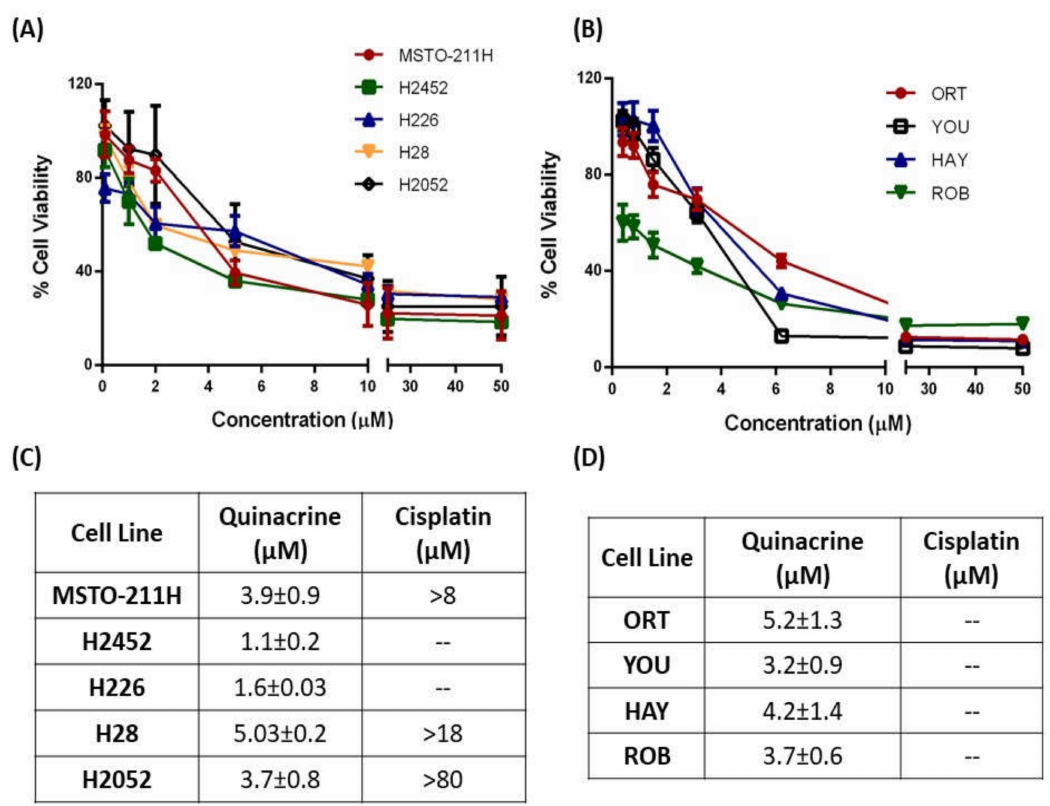
Figure1. Cytotoxicityscreenforquinacrine(QA)andcisplatin(CS)onimmortalizedandpatient-derived primary MPM cells. ( A ) Concentration dependent cytotoxic activity of quinacrine (QA) in immortalized mesothelioma cell lines MSTO-211H, H2452, H226, H28, and H2052 and ( B ) patient-derived mesothelioma cell lines ORT, YOU, HAY, and ROB. Briefly, 2500 cells / well were plated in 96-well plates, and following overnight attachment, were exposed to various concentrations of either cisplatin or quinacrine for 72 h. After 72 h, cytotoxicity was measured with Cell Titer Blue assay kit. ( C ) Mean IC 50 values for QA and cisplatin calculated from the cell toxicity data obtained using GraphPad Prism for all immortalized cell lines. ( D ) IC 50 values for QA and cisplatin for all patient-derived cell lines Data are presented as % cell viability and represent mean ± SD (average of 3 individual experiments with n =